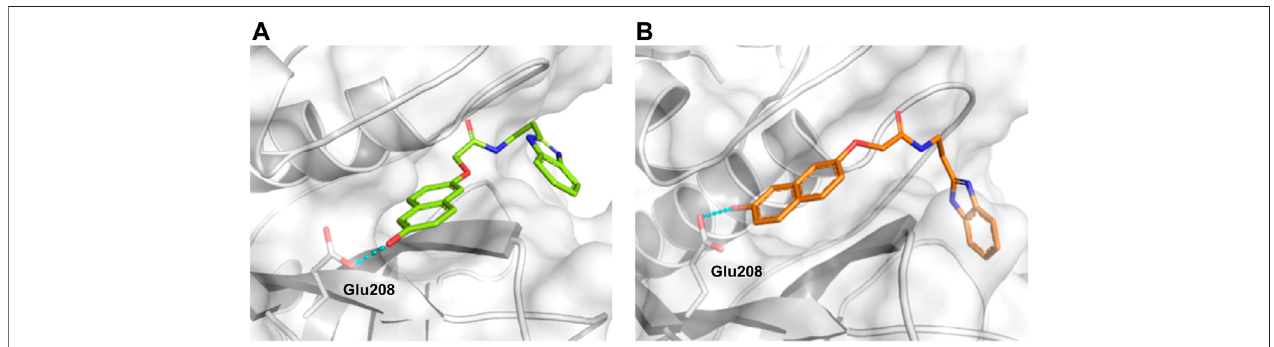
FIGURE 4 | Molecular docking predicted the binding conformations of compounds 10 (A) and 11 (B) in complex with cruzain (PDB 3KKU, 1.28 Å), showing the formationofhydrogenbonds(dashedlines)betweenthehydroxylgroupsandGlu208.Bindingsiteresidues(carboningray)andcompounds 10 and 11 (carboningreen and orange, respectively) are shown as sticks.